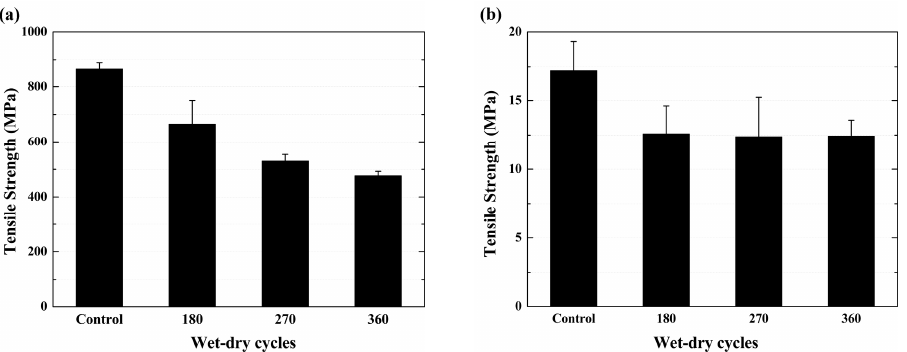
Figure 6. Tensile strength of the specimens as a function of wet–dry cycles, ( a ) BFRP sheet; ( b ) epoxy resin matrix.